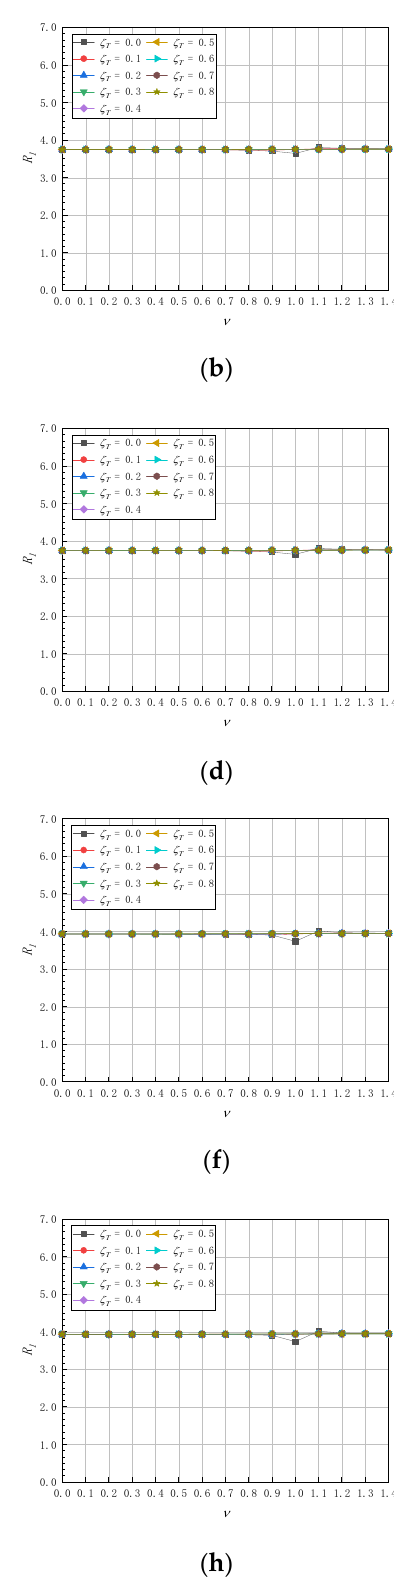
( d ) Figure 7. Schemes of horizontal assembly formed by ( a ) 3, ( b ) 6, ( c ) 10 and ( d ) 20 modules. In this paper, the stepwise search method was adopted to optimize the tuning fre ‐ quency ratio and damping ratio with the step size of 0.1. The constraints are as described